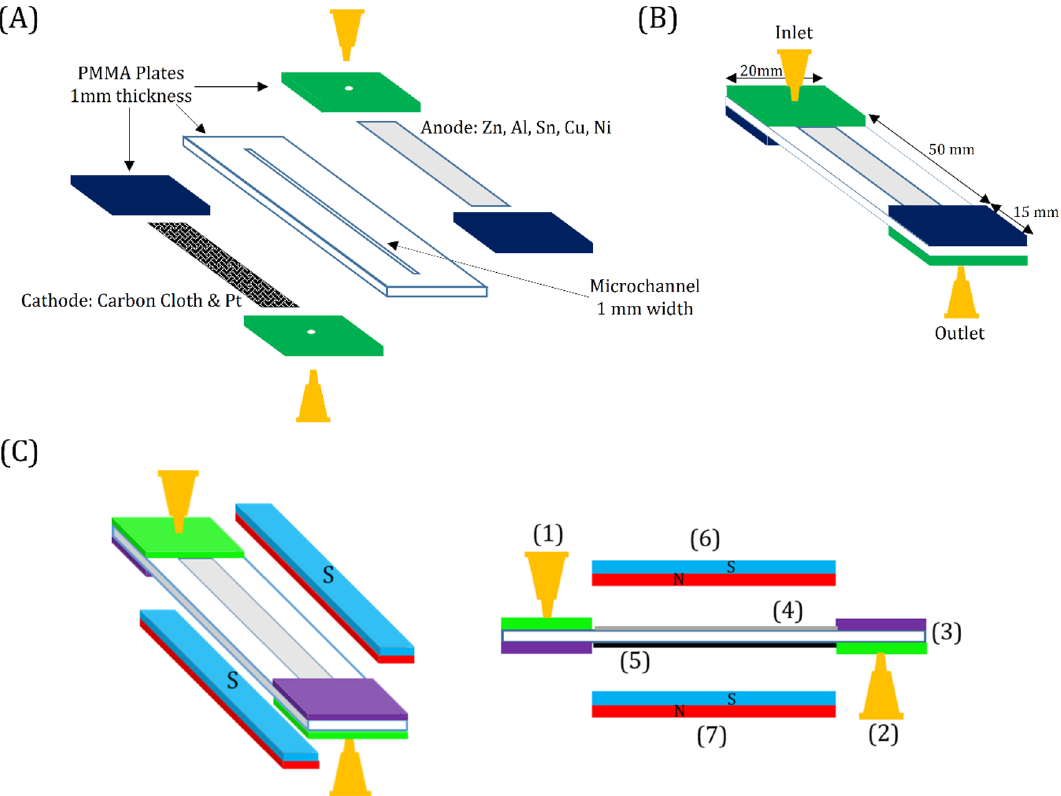
Figure 1. Schematic illustration of the microfluidic MFC: ( A ) exploded diagram and ( B ) fabricated device. ( C ) Schematic details of applying a static magnetic field by Nd–Fe–B permanent magnets. (1): substrate inlet; (2): substrate outlet; (3) microchannel and cell body; (4): anode; (5): cathode; (6): upper magnet; (7): lower